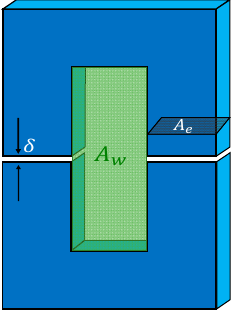
Figure 12. O-type ferrite core for each flyback transformer.